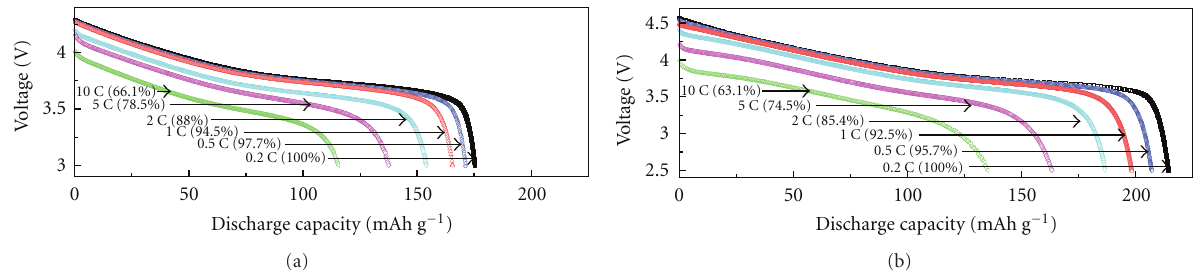
Figure 10: Typical discharge curves of Li/Li[Ni 0 . 5 Mn 0 . 3 Co 0 . 2 ]O 2 cell in the voltage range of (a) 3.0–4.3 V and (b) 2.5–4.6 V at various current densities at 25 ◦ C.